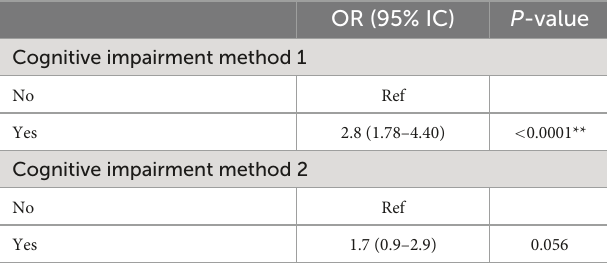
TABLE 2 Clinical characteristics, comorbidity, and Lifestyle risk factors, of the participants comparing people without Type 2 Diabetes Mellitus and participants with Type 2 Diabetes Mellitus.